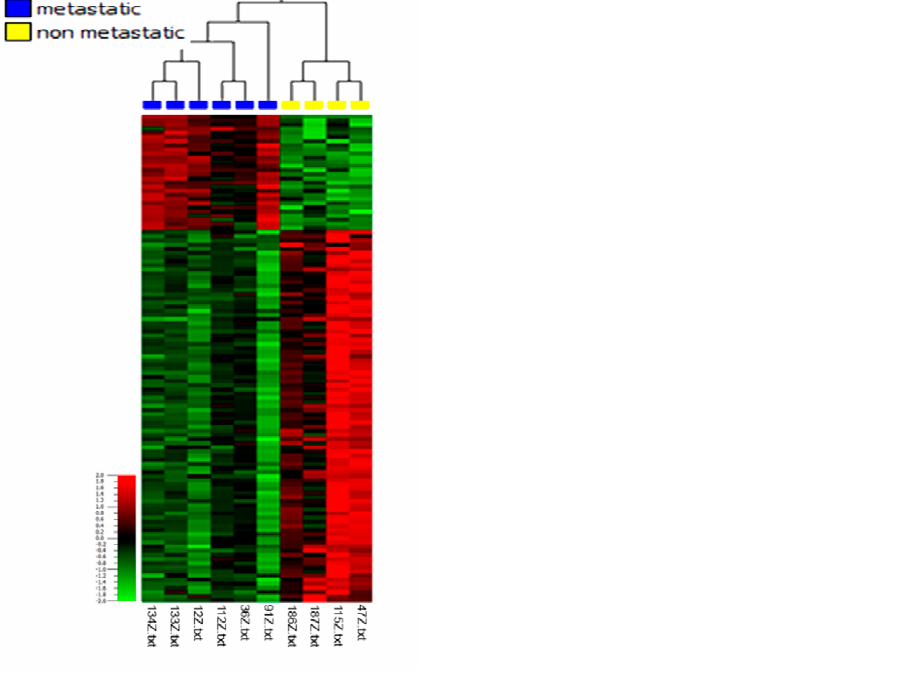
Figure 4. Heat map after unsupervised hierarchical clustering of differentially expressed miRNAs in metastatic versus non-metastatic (HPV-negative) usual PSCC ( p ≤ 0.01; q ≤ 0.08; fold change ≥ 2). Due to the low frequency of basaloid tumors and the histological similarities between warty, basaloid, and warty–basaloid tumors, these three PSCC subtypes were combined into a single group. A comparison of this HPV-positive group to the related normal tissues revealed 247 miRNAs that were differently expressed ( p ≤ 0.05, q ≤ 0.17). The majority of the miRNAs ( n = 245) were downregulated, while only two were upregulated (Figure 5). Here, miR-181d-5p had the highest expression, with a 3.41-fold increase, whereas miR- 211-5p had the lowest expression, with a 16.96-fold decrease in tumor tissue (Table S5). The analysis of microarray data did not reveal statistically significantly deregulated miR- NAs between metastatic and non-metastatic tissues in these subtypes ( q ≥ 0.79; Figure S3).